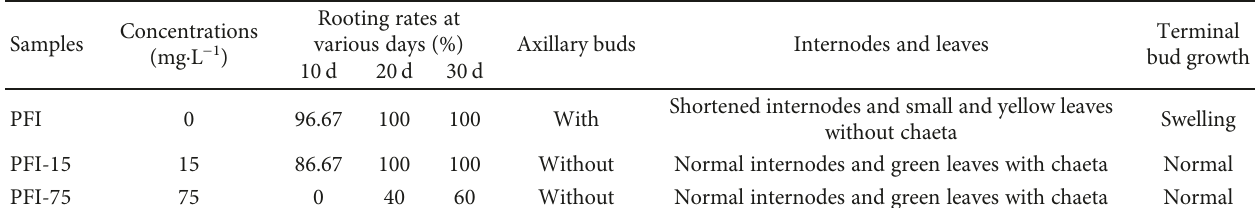
Table 2: Rooting rates and morphologic changes in PaWB-infected P. fortunei with DMS treatment. Samples